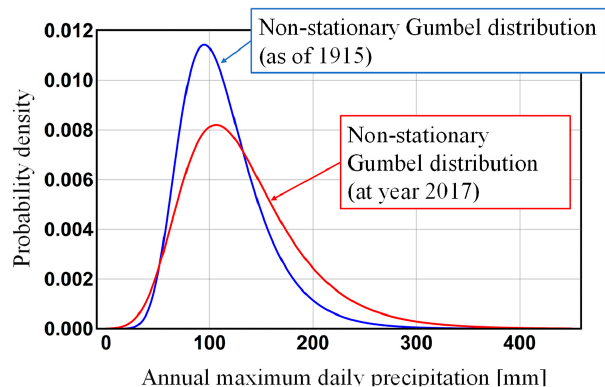
Figure 3. Time variation of the non-stationary Gumbel distribution applied to the observed data of annual maximum daily precipitation over 142 years (from 1876 to 2017) at the observation station Tokyo. The blue solid line represents the non-stationary Gumbel distribution in 1915, whereas the red solid line represents the non-stationary Gumbel distribution in 2017.